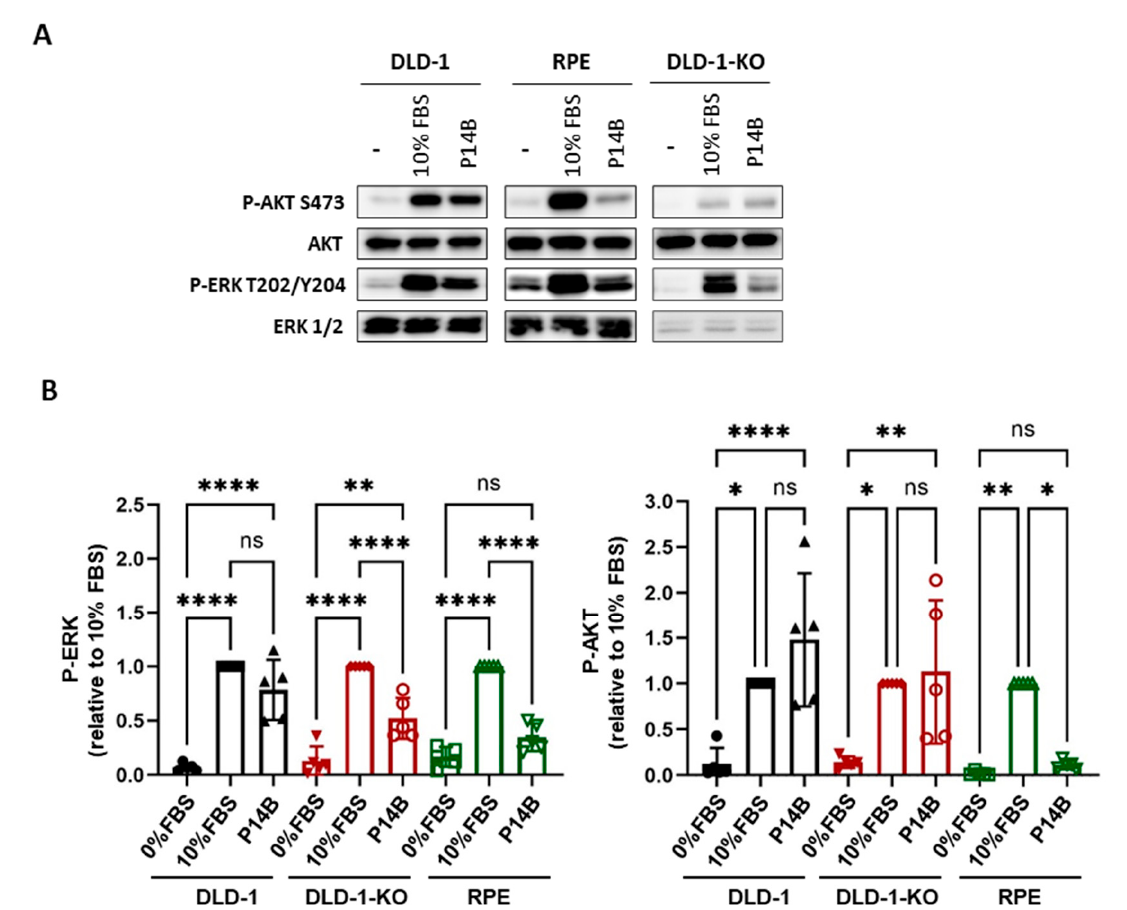
Figure 6. P14B treatment of CRC cells expressing oncogenic KRAS increases endogenous downstream RAS signaling. ( A ) DLD-1, DLD-1-KO and hTERT-RPE starved cells were incubated with 100 µ M of P14B for 3 h and the levels of activation of ERK and AKT were analyzed by WB. Specific antibodies against the active phosphorylated and total proteins were used. ( B ) Graph showing quantification of four independent experiments. Differences were assessed using a one-way ANOVA and Multiple Comparisons Test, and considered significant when p ≤ 0.05. *: p -value < 0.05; **: p -value < 0.01; ****: p -value < 0.0001; and ns: non-significant.